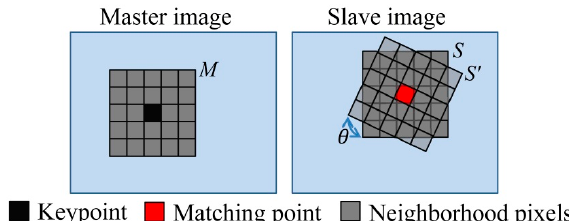
Figure 3. Schematic diagram for the pixel-level ice flow of a curved outlet glacier. M is the reference chip. S and S ʹ are match chips . The red pixel in the slave image is the matching point which corresponds to the keypoint in the master image.